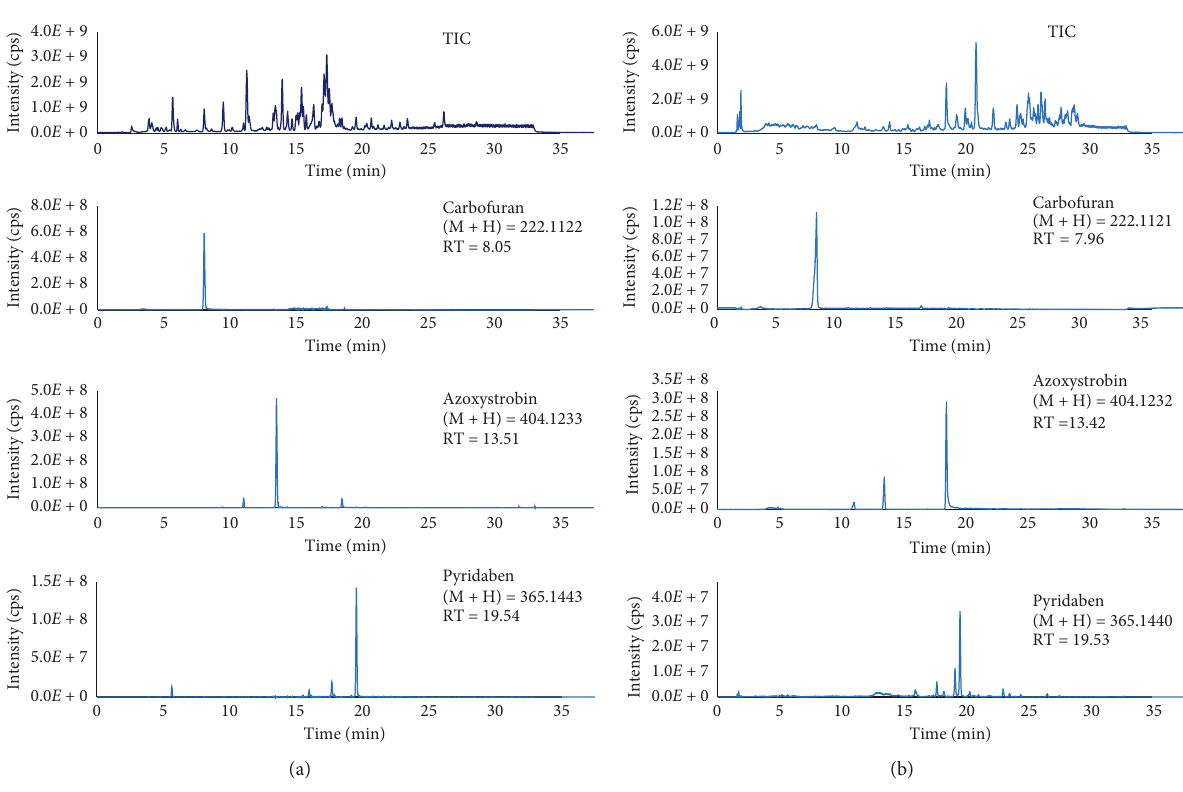
Figure 3: The total ion and extracted ion chromatogram of the target analytes in the standard solution (a) and in the matrix-match solution (b) on the Thermo Hypersil GOLD PFP column, and other operating conditions are mentioned in Section 2.2. The first and second numbers on the right upper are mass-to-charge ratio and retention time, respectively. Table 2: Mass and mass accuracy of three representative pesticides in the standard solution and in the matrix-match solution. Chemical No Analytes